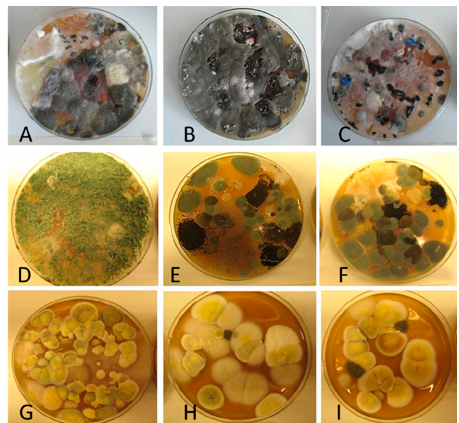
Figure 9. Fungal colonies sampled from the outdoor air and from the extract air filter dust before and after the ventilation intervention. The outdoor air and dust contained black Curvularia ‐ like colonies ( A – C ). Extract air filter sampled before the ventilation intervention contained green Trichoderma colonies ( D ), and green Penicillium and black Aspergillus colonies ( E , F ). Extract air filter sampled after the ventilation intervention contained yellow Penicillium colonies and yellow Aspergillus colonies ( G – I